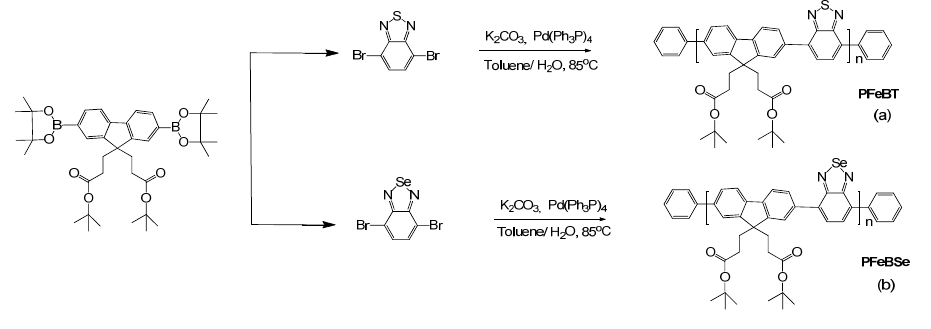
Figure 4. Synthesis of the donor-acceptor copolymers. ( a ) PFeBT,